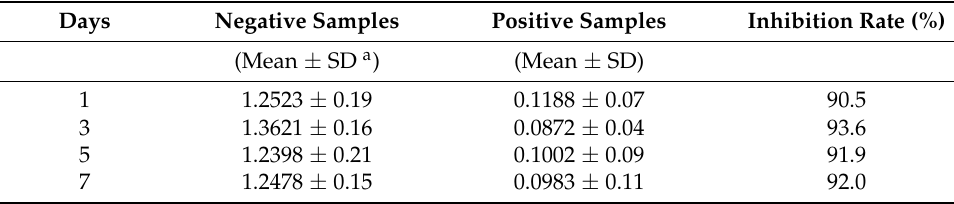
Table 3. Stability experiments for TRFICA ( n = 3) at 37 ◦ C.